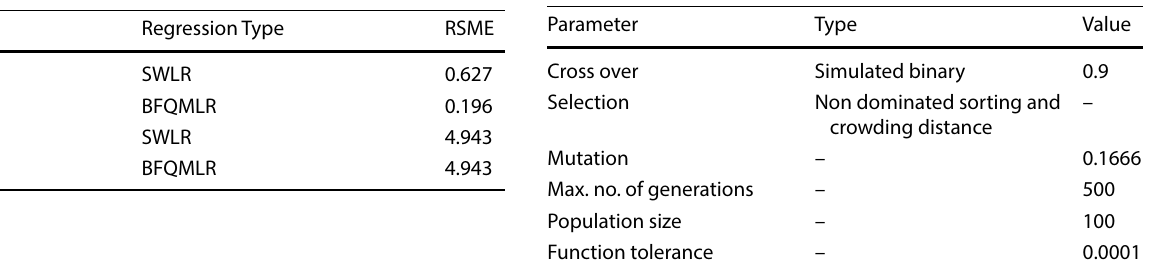
Table 12 Type and value for NSGA-II